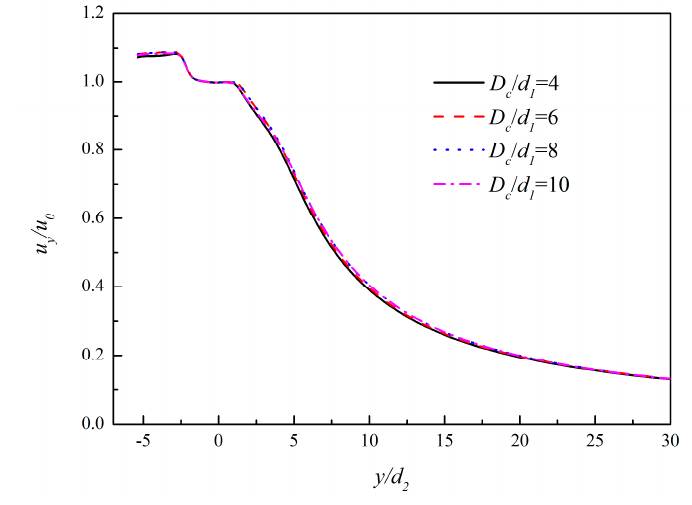
Figure 11. The axis velocity attenuation curves of different cavity diameters.